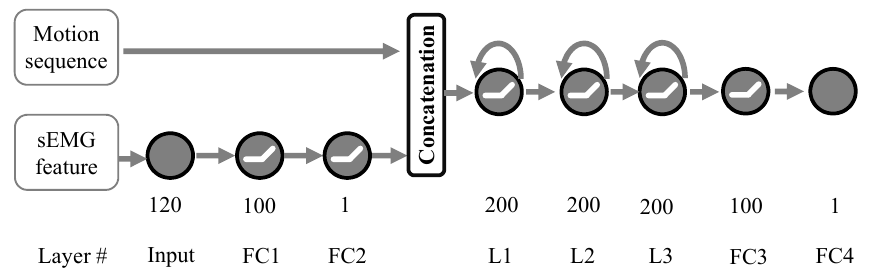
Figure 6. The architecture of motion prediction